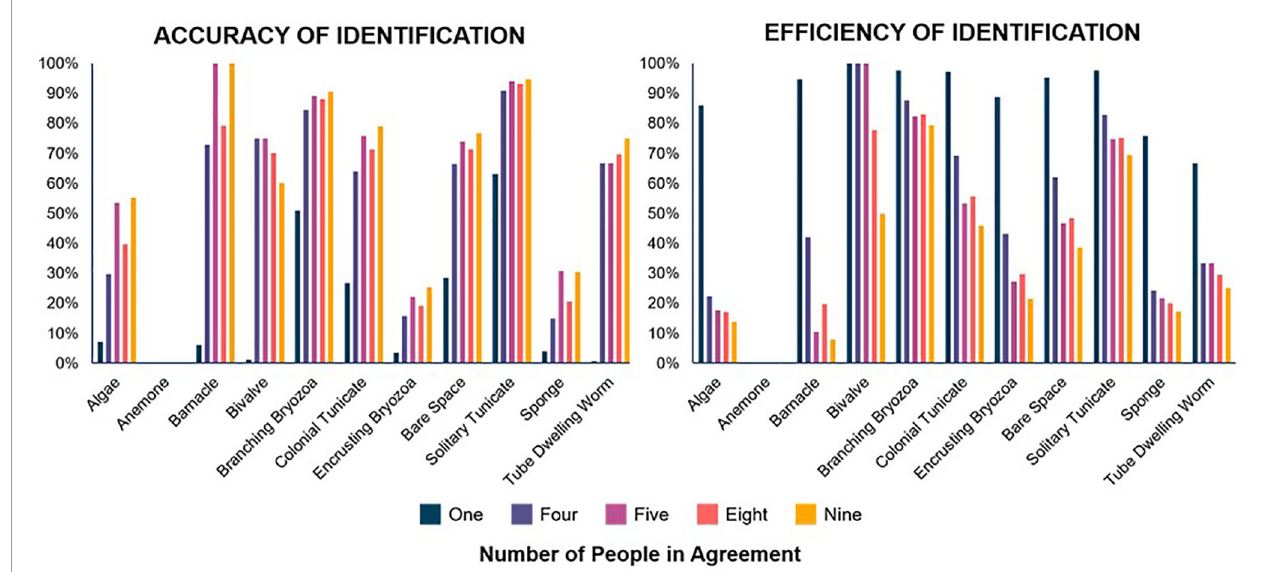
FIGURE 2 | Accuracy (left) and ef fi ciency (right) of the four proposed consensus methods and a single person. Accuracy shows the proportion of volunteer identi fi cations of each taxa that were correct. Ef fi ciency shows the proportion of the actual total of each taxa correctly identi fi ed by volunteers. Graphs compare identi fi cations made by one volunteer, four people in agreement, fi ve people in agreement, eight observers without regard to agreement, and nine observers. Four agreed (purple) and fi ve agreed (pink) are more ef fi cient than eight observers (coral) and nine observers (yellow) but accuracy is somewhat variable between all methods. It is common that at least one of the 10 people surveyed will identify each true identi fi cation (ef fi ciency), but overall single person accuracy is more often worse.